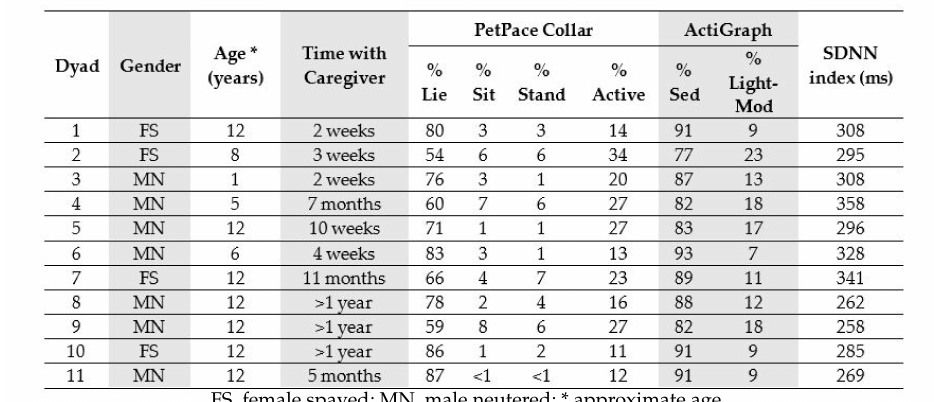
Table 5. Dogs: position, activity, and HRV over 24-hour period.